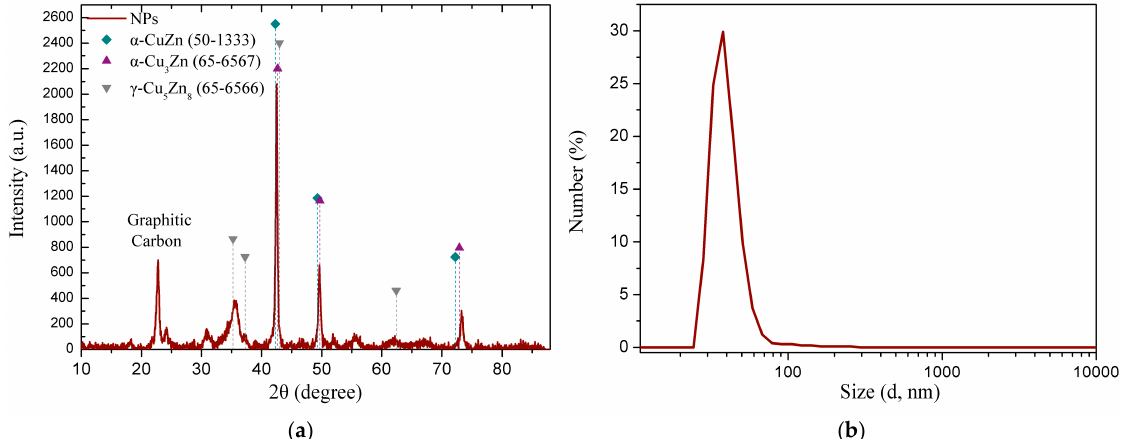
Figure 1. The X-ray di ff raction (XRD) patterns of CuZn nanoparticles (NPs) ( a ), and the size distribution (diameter in nm) of the aqueous suspensions of CuZn NPs evaluated by dynamic light scattering (DLS) numbers measurements ( b ).